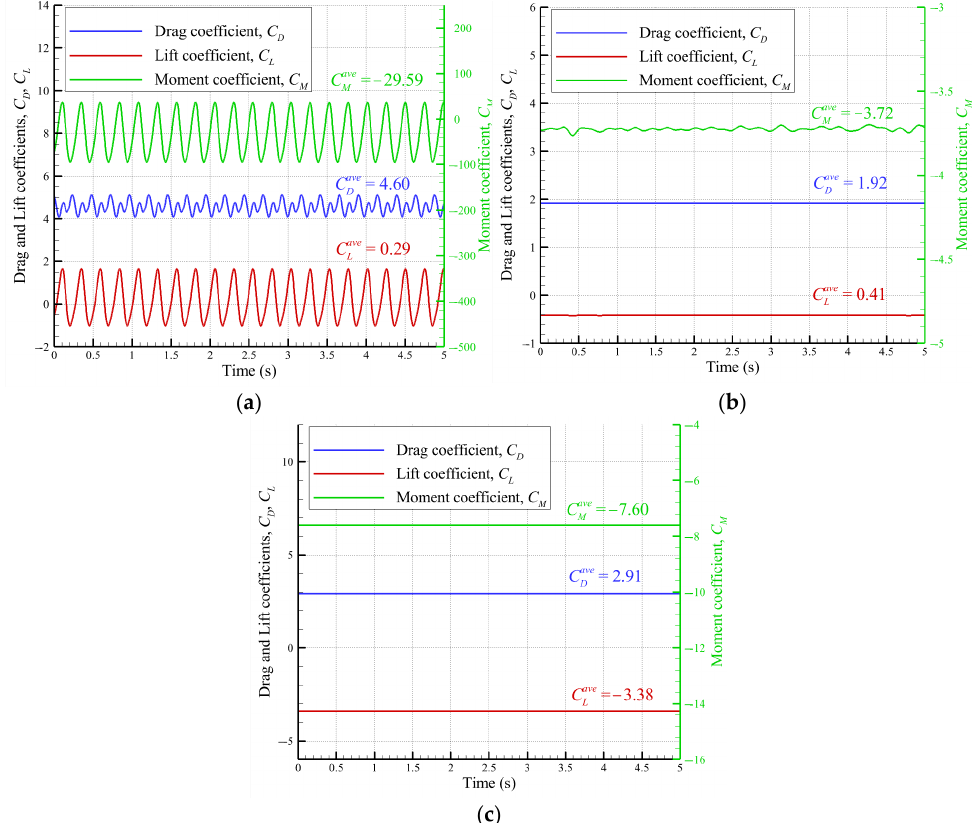
Figure 5. The time evolution of hydrodynamic force coefficients: ( a ) AR = 0.208, Re = 8689.223, ( b ) AR = 2.036, Re = 12,958.475, ( c ) AR = 3.989, Re =